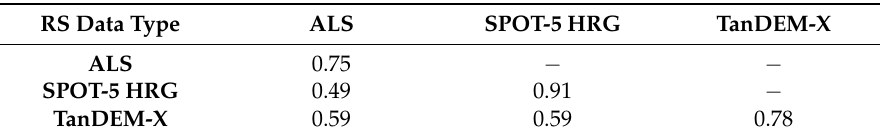
Table 7. Average correlation for the residuals of volume per hectare.